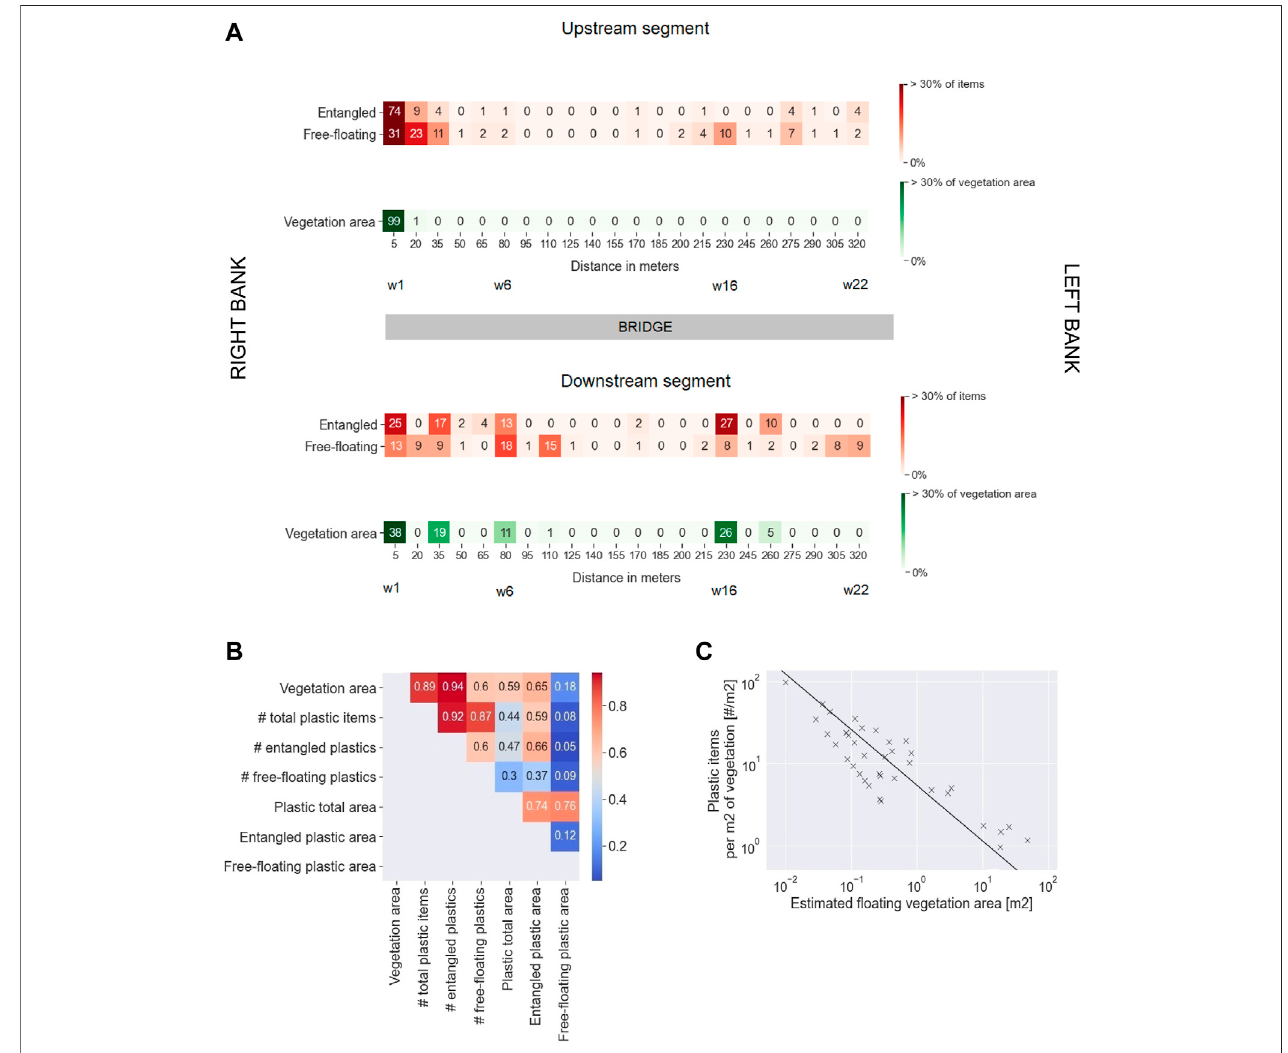
FIGURE 3 | (A) Distribution of vegetation and macroplastics along the river width [%] upstream and downstream the bridge. (B) Correlation matrix of measured metrics.ThePearsoncorrelationcoef fi cientwasused.Redshowshighestcorrelationscoresbetweenvariables,whileblueshowslowerscores.All p -valuesare < 0.01so all correlation scores show signi fi cant relationships between variables (C) Plastic accumulation within hyacinth patches: number of plastic items per m 2 of vegetation in relation to the estimated vegetation area in m 2